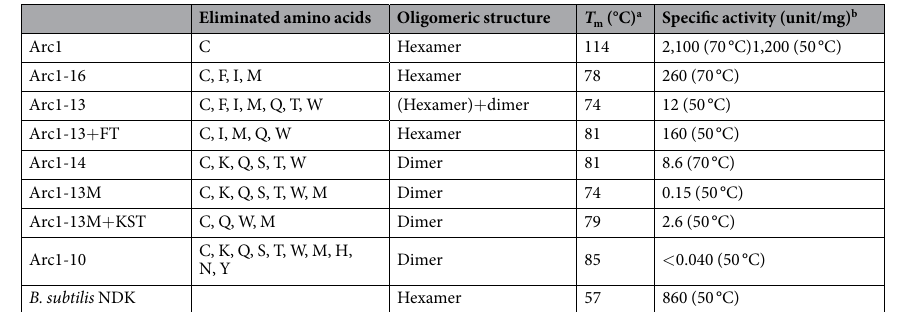
Table 1. Summary of the reconstructed NDK and its simplified variants as well as an extant mesophilic NDK. a T m is the temperature corresponding to 50% denaturation as determined by monitoring the change in ellipticity at 222 nm (Fig. 2). b Reaction temperatures are given in parentheses. The specific activities of Arc1, Arc1-16, and Arc1-14 were determined at 70 °C because the maximum activity was observed that temperature under the conditions used, but the activities of other proteins were determined at 50 °C to avoid the effect of protein